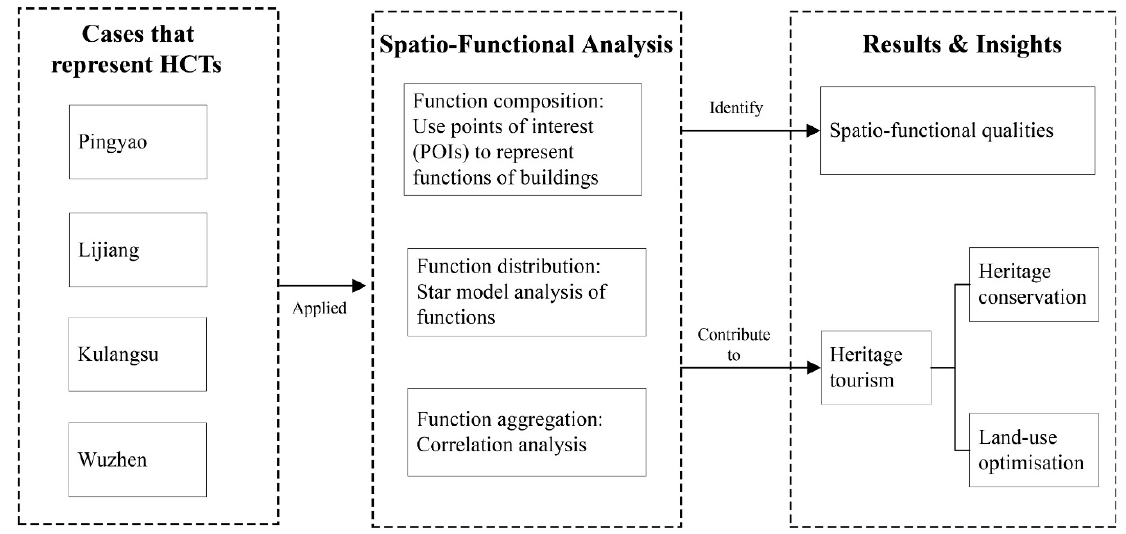
Figure 1. Research framework of this study.